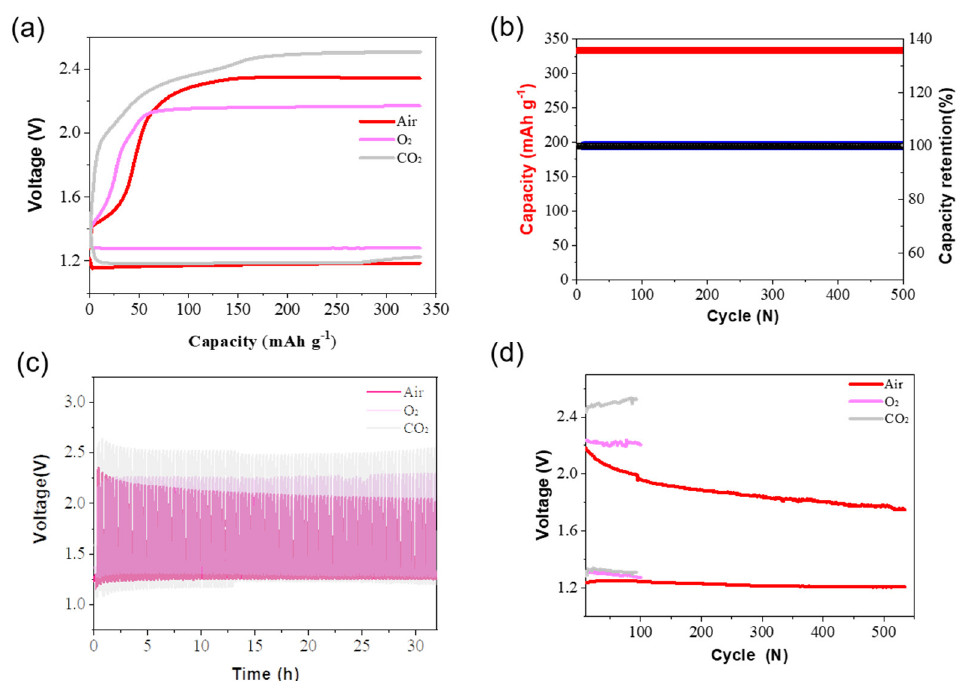
Figure 4. Electrochemical performance of the Zn–air battery, Zn-O 2 battery, and Zn-CO 2 battery using a heterogeneous MoS 2 catalyst. ( a ) The discharge and charge curves of the Zn–air battery, Zn-O 2 battery, and Zn-CO 2 battery using a heterogeneous MoS 2 catalyst at the 1st cycle with a limited capacity of 330 mAh g − 1 and a current density of 0.5 mA cm − 2 . ( b ) The specific capacity and corresponding capacity retention of the aqueous Zn–air battery, Zn-O 2 battery, and Zn-CO 2 battery during cycling with a current density of 0.5 mA cm − 2 . ( c ) Voltage–time curves of the Zn–air battery, Zn-O 2 battery, and Zn-CO 2 battery, respectively, for cycling over 30 h with a limited capacity of ~330 mAh g − 1 at 0.5 A cm − 2 . ( d ) The discharge and charge voltage change of the Zn–air battery, Zn-O 2 battery, and Zn-CO 2 battery for long-term cycling with a limited capacity of ~330 mAh g − 1